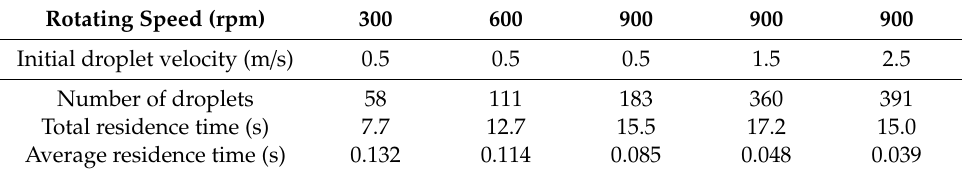
Table 3. Average residence time under various initial droplet velocities and rotating speeds. Rotating Speed